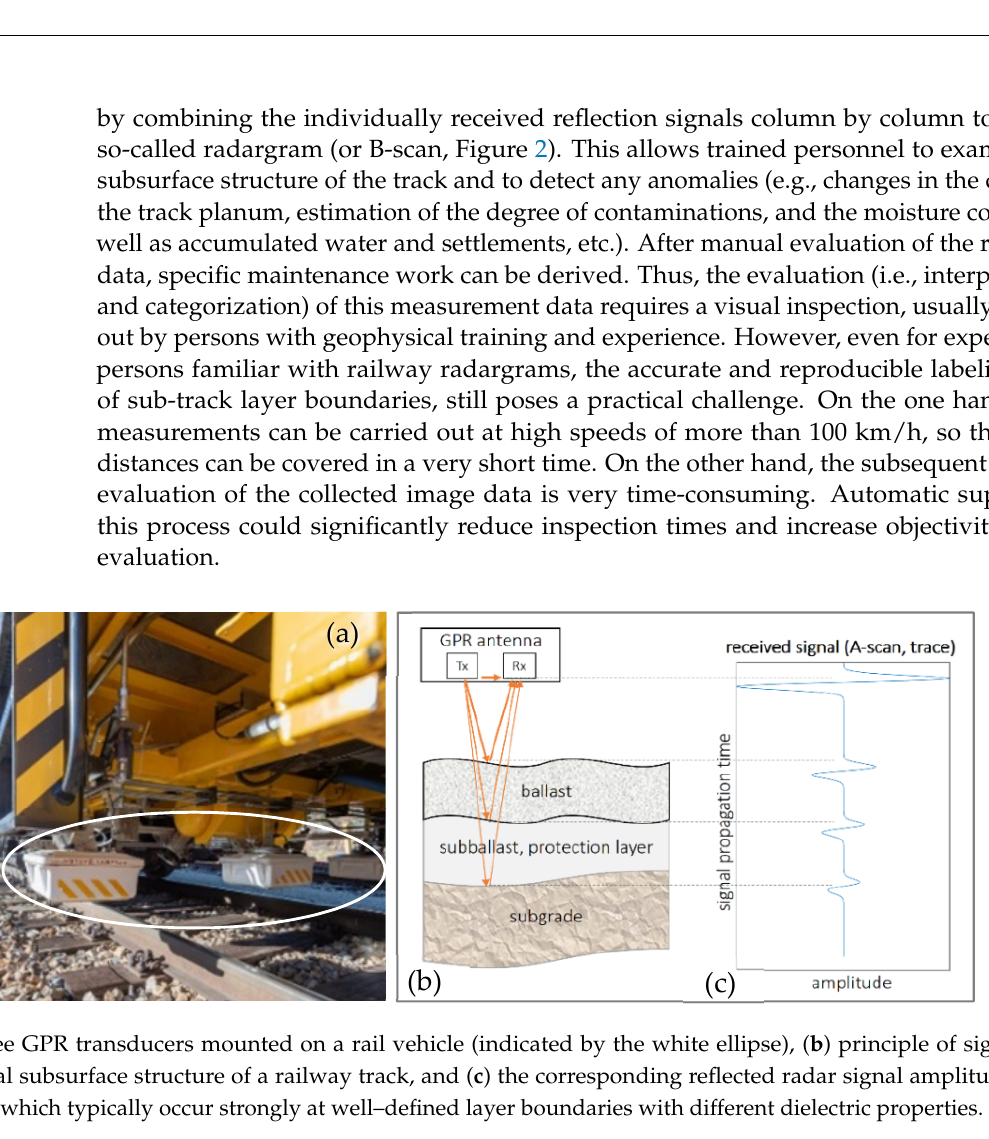
at well–defined layer boundaries with different dielectric properties.